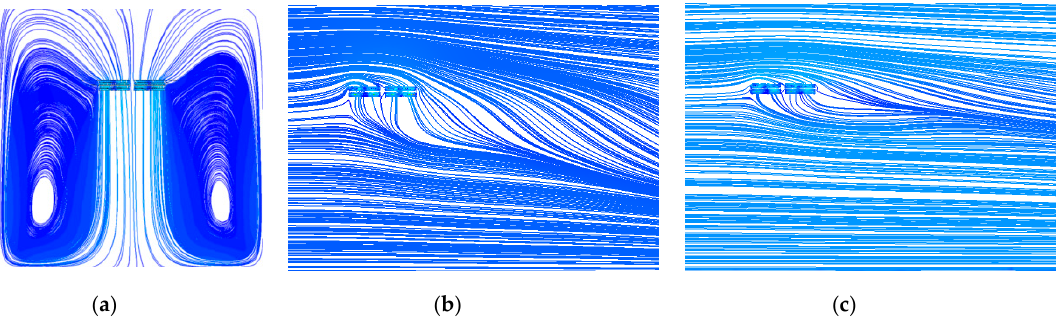
Figure 10. Streamline distribution: ( a ) 0 m/s; ( b ) 2.5 m/s; ( c ) 4.0 m/s.